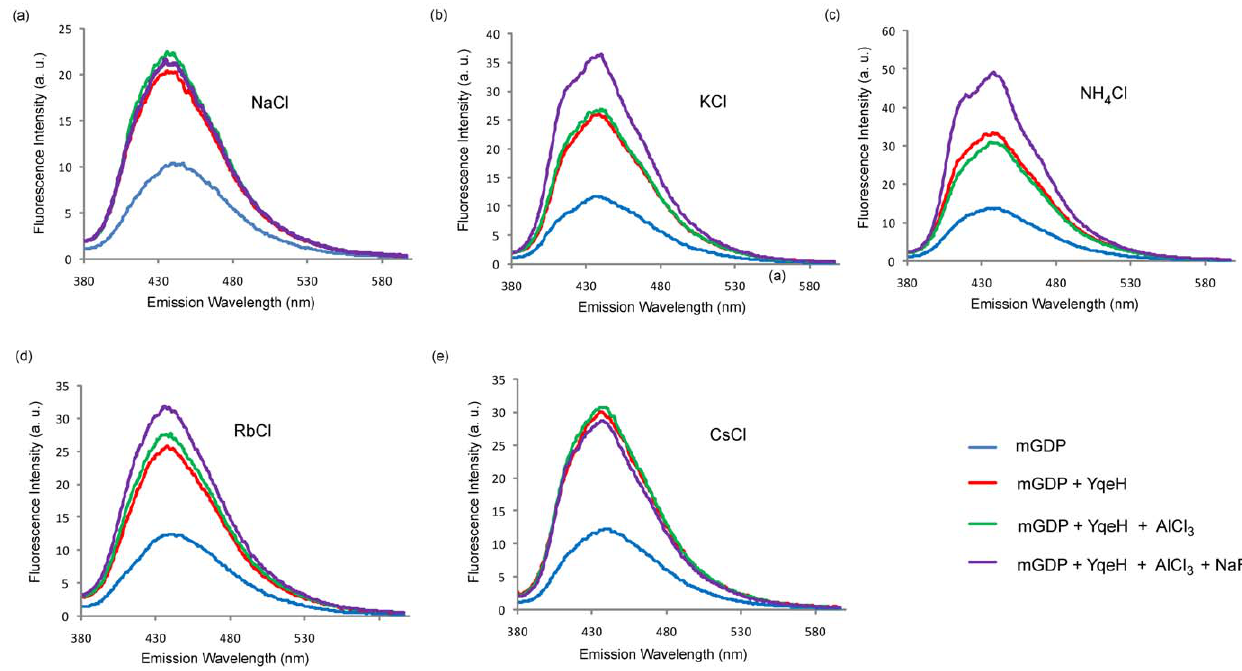
Figure 2. Formation of mGDP ? AlF x complex in the presence of various monovalent salts. The influence of (a) NaCl, (b) KCl, (c) NH 4 Cl, (d) RbCl and (e) CsCl on nucleotide binding was examined by measuring fluorescence intensity (in arbitrary units) of mant-GDP ( l ex - 355 nm, l em - 440 nm). The intrinsic fluorescence by mGDP (blue curve) is enhanced after the addition of YqeH (red curve). This is followed by addition of AlCl 3 in the same reaction mixture which shows no appreciable change (green). Addition of NaF (purple), however, results in an increased fluroscence in presence of (a) K + (c) NH 4 + and (d) Rb + suggesting the formation of mGDP ? AlF x complex in presence of these ions. doi:10.1371/journal.pone.0009944.g002 PLoS ONE |